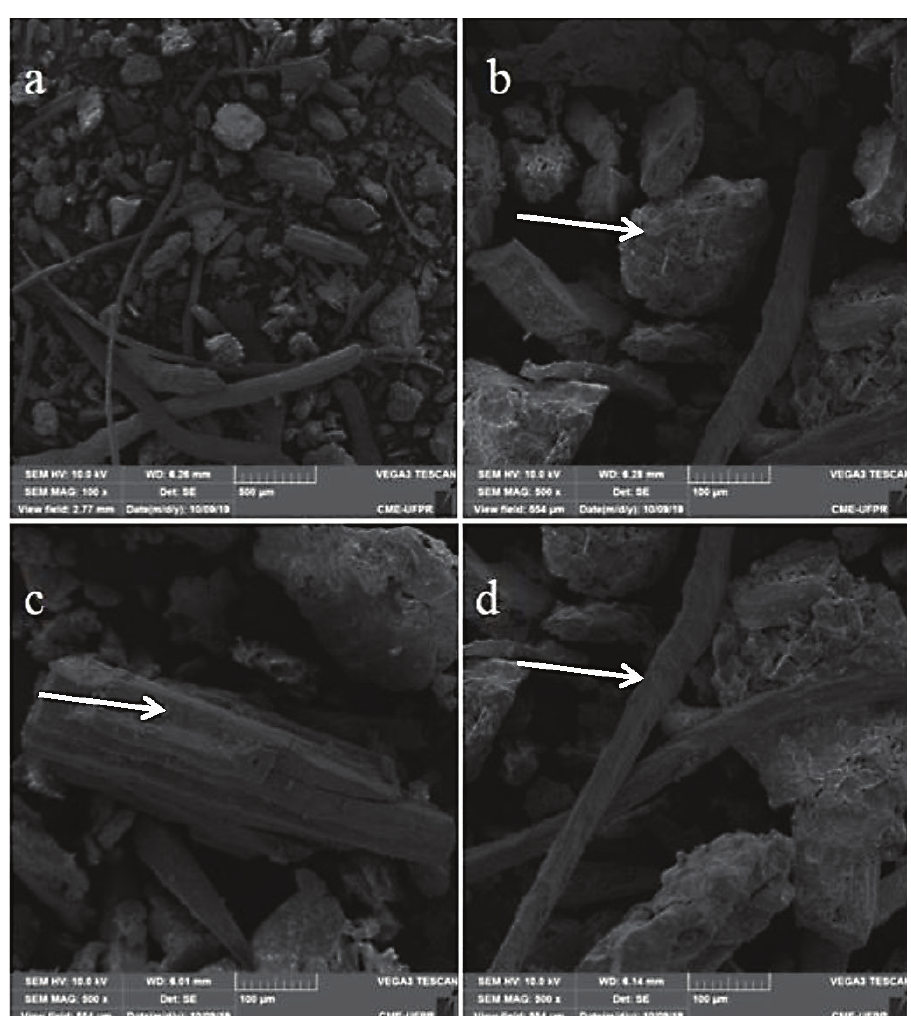
Fig. 3 – Scanning Electron Microscopy images of Açaí seeds powder samples (MESH <80) with acid treatment at 100x magnifica- tion (a), S1 at 500x magnification (b), S2 at 500x magnification (c), and S3 at 500x magnification